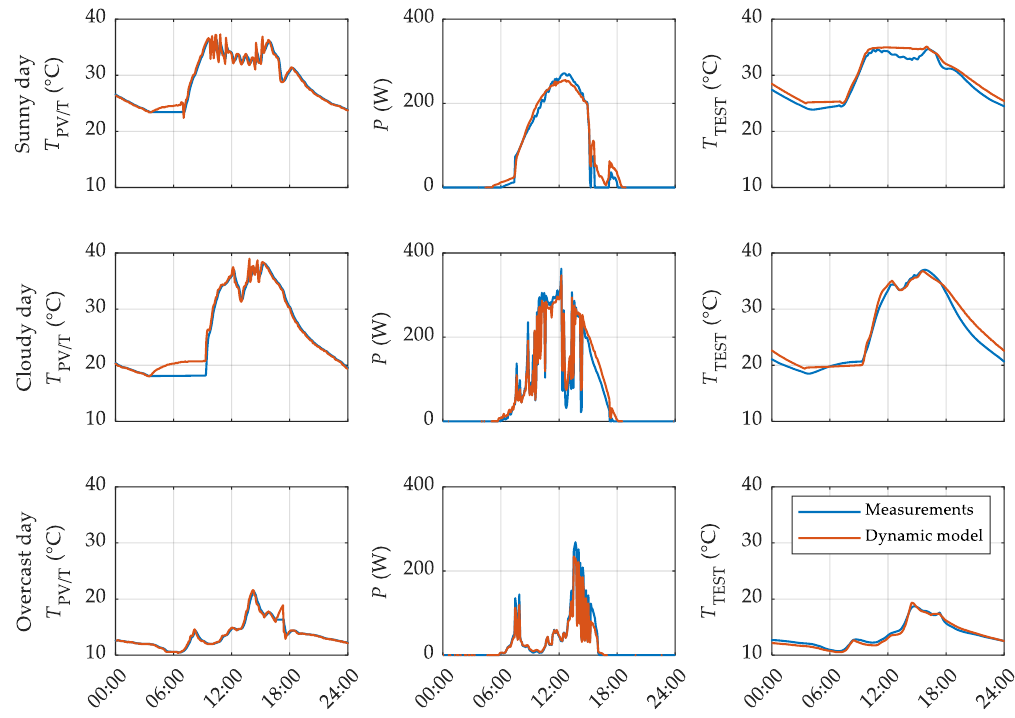
Figure 12. Validation of the dynamic model of a PV/T collector and TEST with measurements ( T PV/T , P , T TEST ) for three different weather conditions: sunny, cloudy, and overcast.